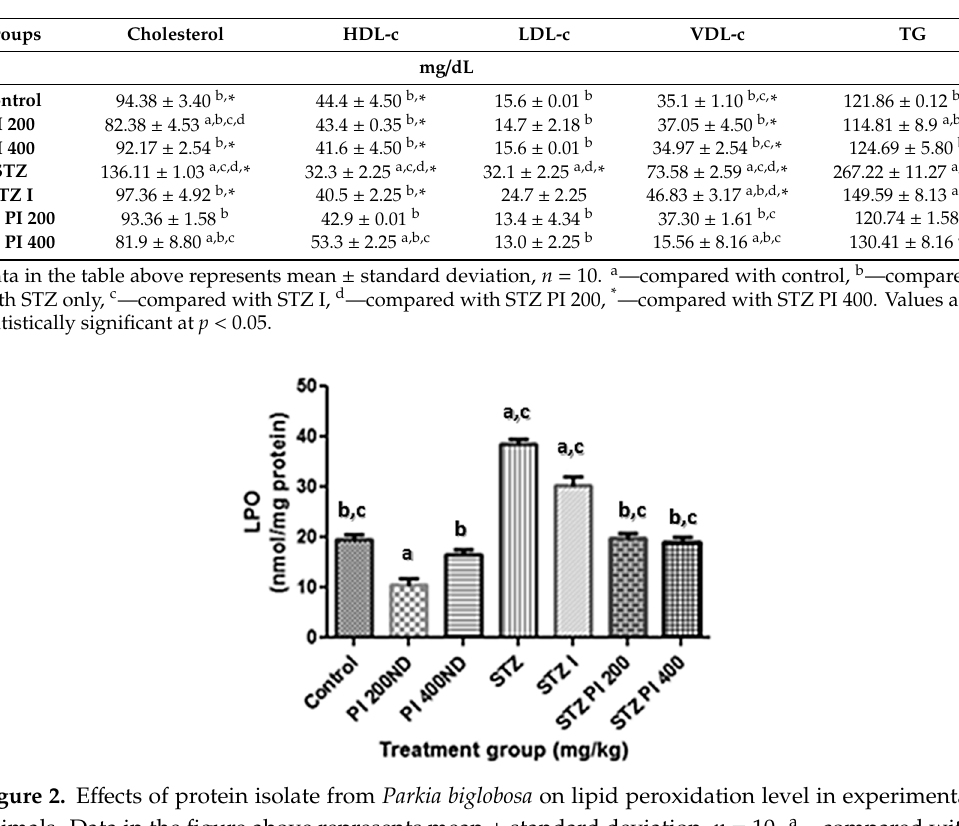
Table 1. Effect of protein isolate from Parkia biglobosa on serum lipid profile in experimental animals. Groups Cholesterol HDL-c LDL-c